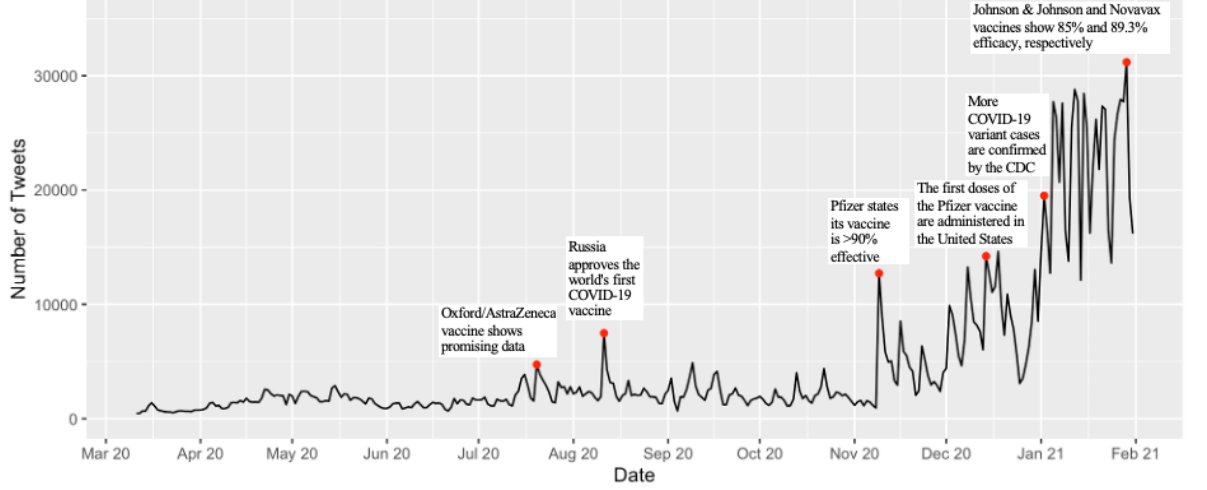
Topic Modeling of COVID-19 Vaccine–Related